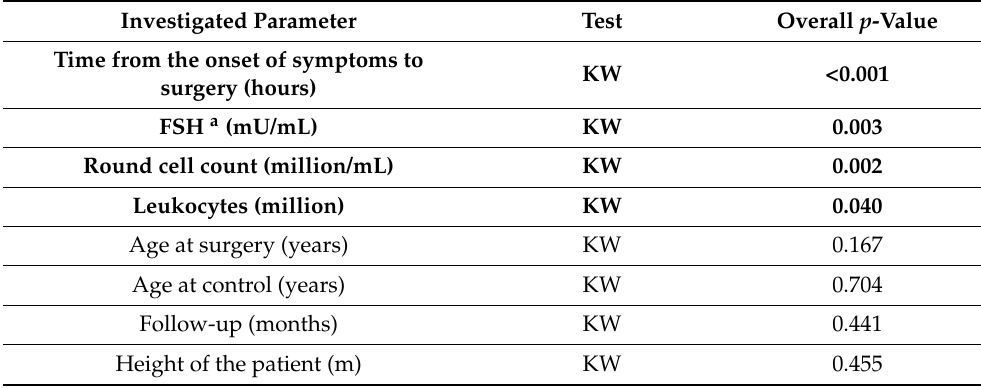
Table 4. Comparison of exploration, detorsion and orchiectomy